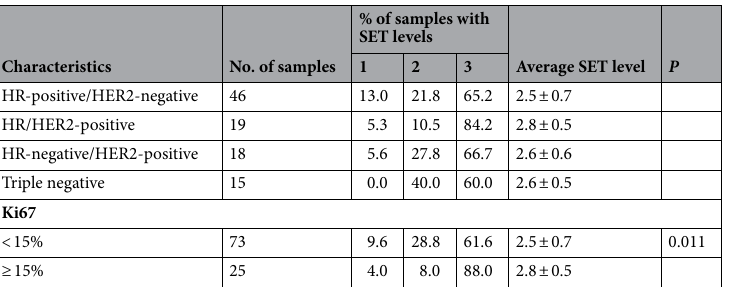
Table 1. Overexpression of SET protein in invasive carcinomas with four clinical subtypes using breast cancer tissue microarray.